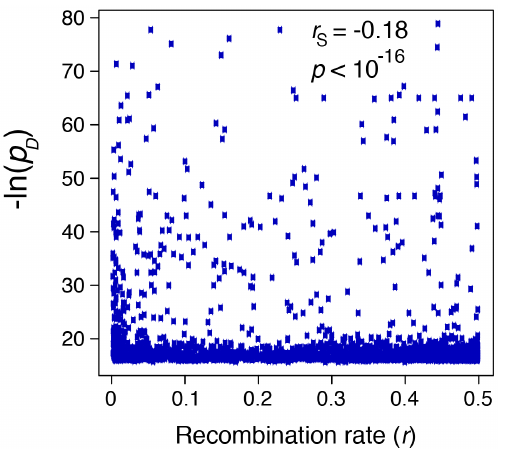
Figure 7. Scatter plot of the maximum value of 2 ln(p D ) in every patch across all chromosomes vs the distance r between the patches. Recombination is expected to make this correlation negative.